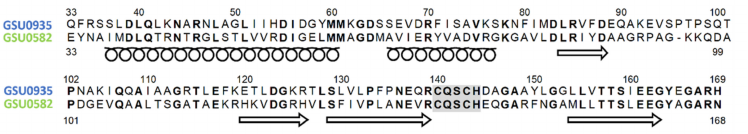
Figure 12. Amino acid sequence alignment of sensor domains GSU0935 and GSU0582 from G. sul- furreducens . The conserved residues are indicated in bold face and the heme binding motif in a gray box. The alignment of the proteins was performed with the basic local alignment search tool (BLAST) [142]. Helical and strand segments are indicated according to PHYRE automatic fold recognition server for secondary structure prediction